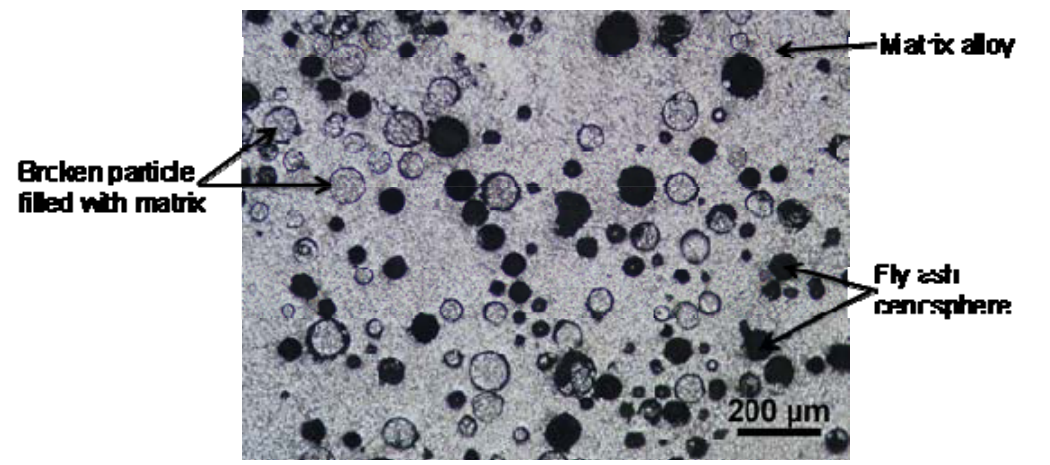
Figure 5. Optical micrograph of AZ91D/fly ash cenosphere composite.